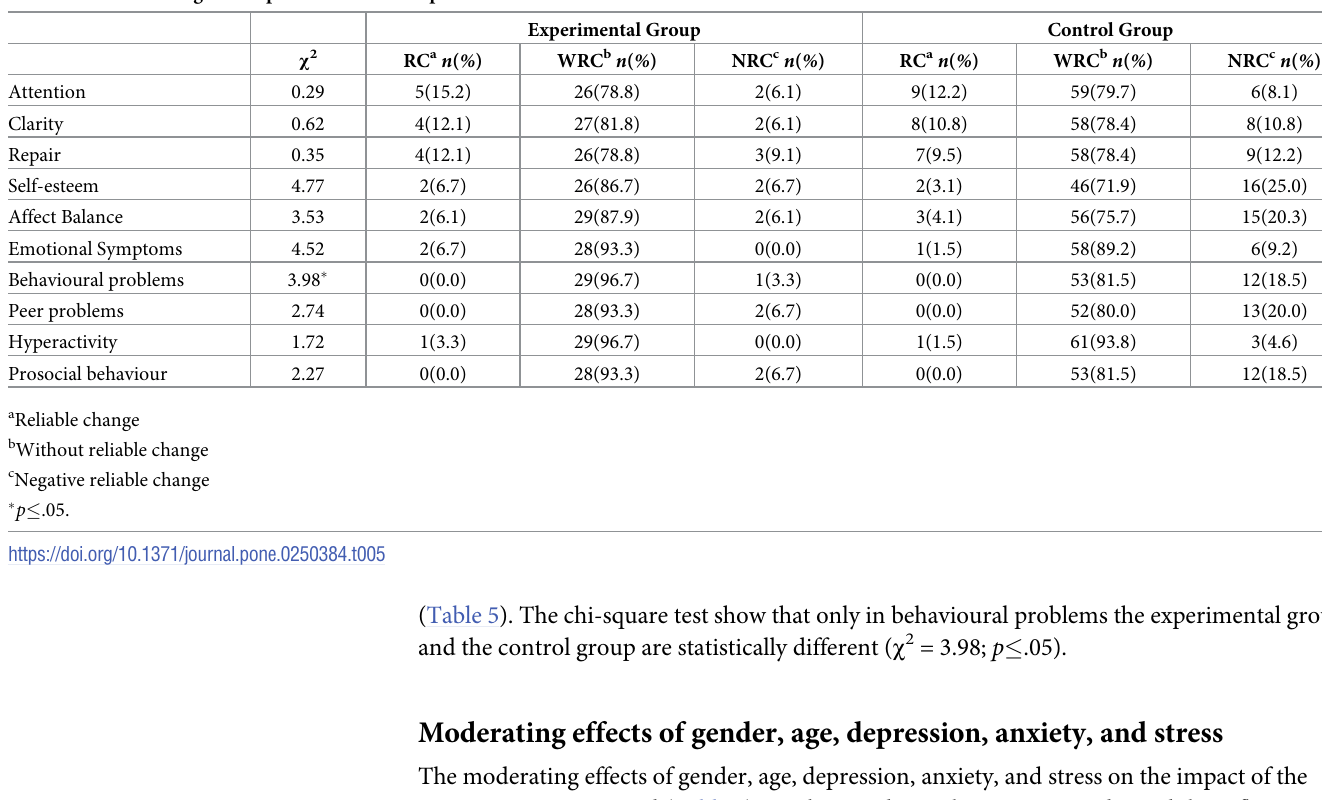
(Table 5). The chi-square test show that only in behavioural problems the experimental group and the control group are statistically different ( χ 2 = 3.98; p � .05).